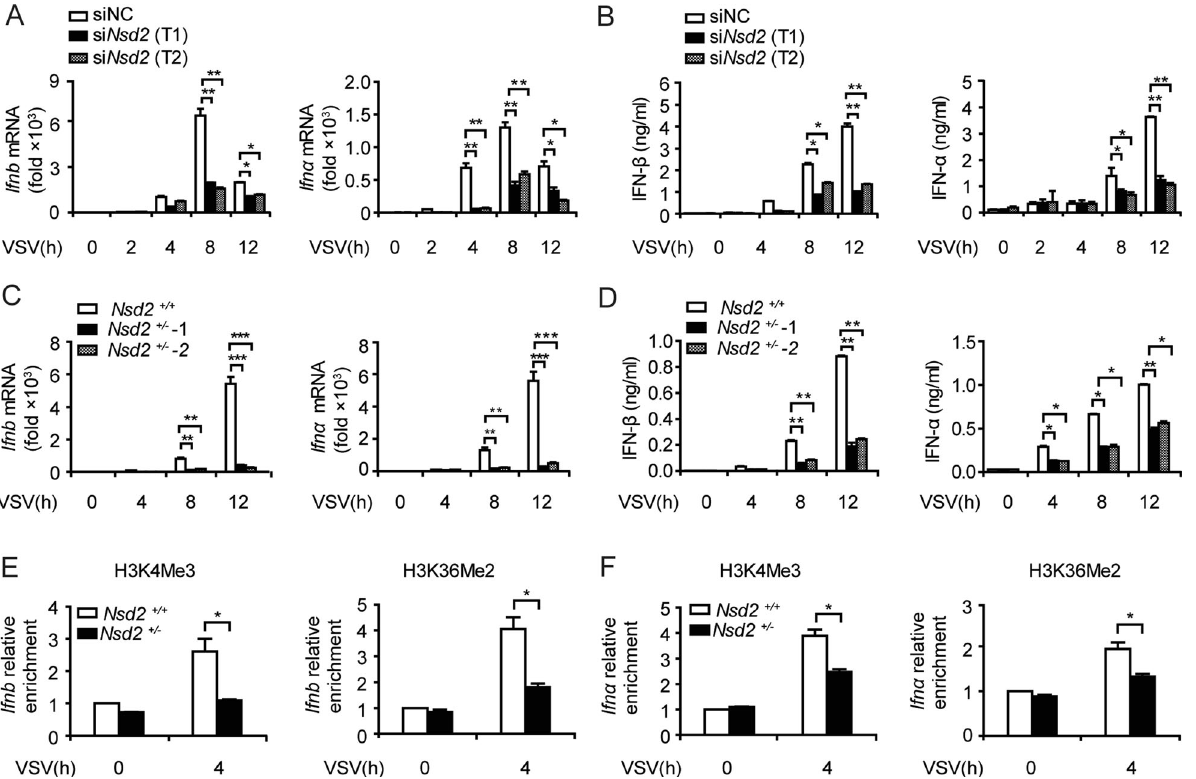
Fig. 5 Inhibition of Nsd2 restrains IFN-I production and histone methylation upon virus infection. A , B qPCR analysis of Ifn-I ( A ) and ELISA analysis of IFN-I ( B ) expression in PMs silenced with two speci fi c Nsd2 siRNAs or NC siRNA in response to VSV (MOI, 1) infection at the indicated times. C , D qPCR analysis of Ifn-I ( C ) and ELISA analysis of IFN-I ( D ) expression in Nsd2 + / + or Nsd2 + / − RAW 264.7 cells infected with VSV (MOI, 1) at the indicated times. E , F ChIP assay of H3K4Me3 and H3K36Me2 in the Ifnb ( E ) and Ifn α ( F ) promoter regions of Nsd2 + / + and Nsd2 + / − RAW264.7 cells infected with VSV (MOI, 1) at the indicated times. * P < 0.05, ** P < 0.01. All data are representative of three independent experiments. ( A – F : mean ±